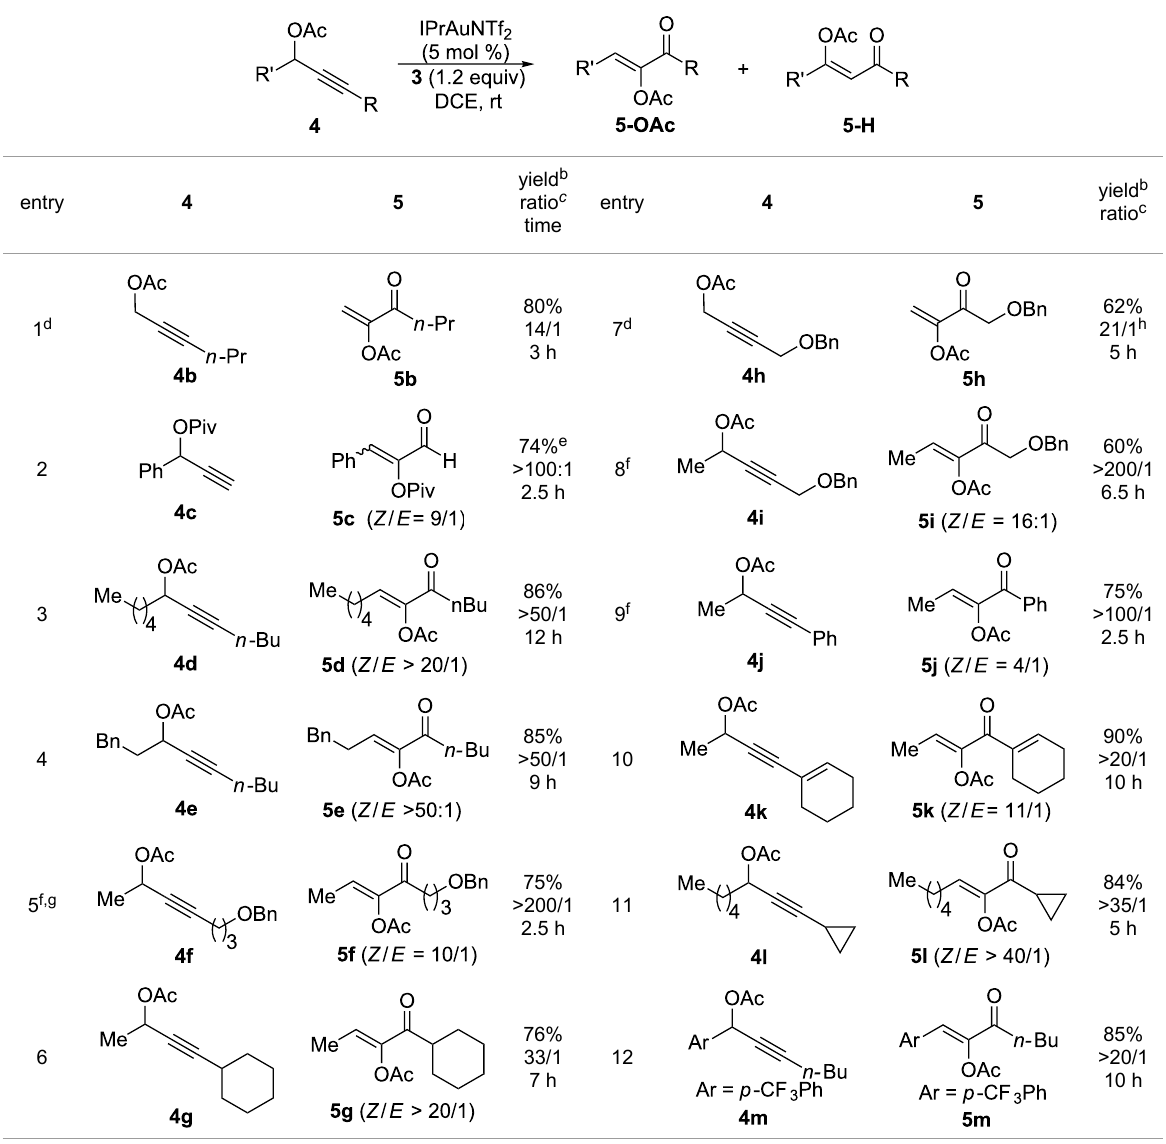
Table 1: Reaction scope studies for the formation of α -acetoxyenones from propargyl acetates. a